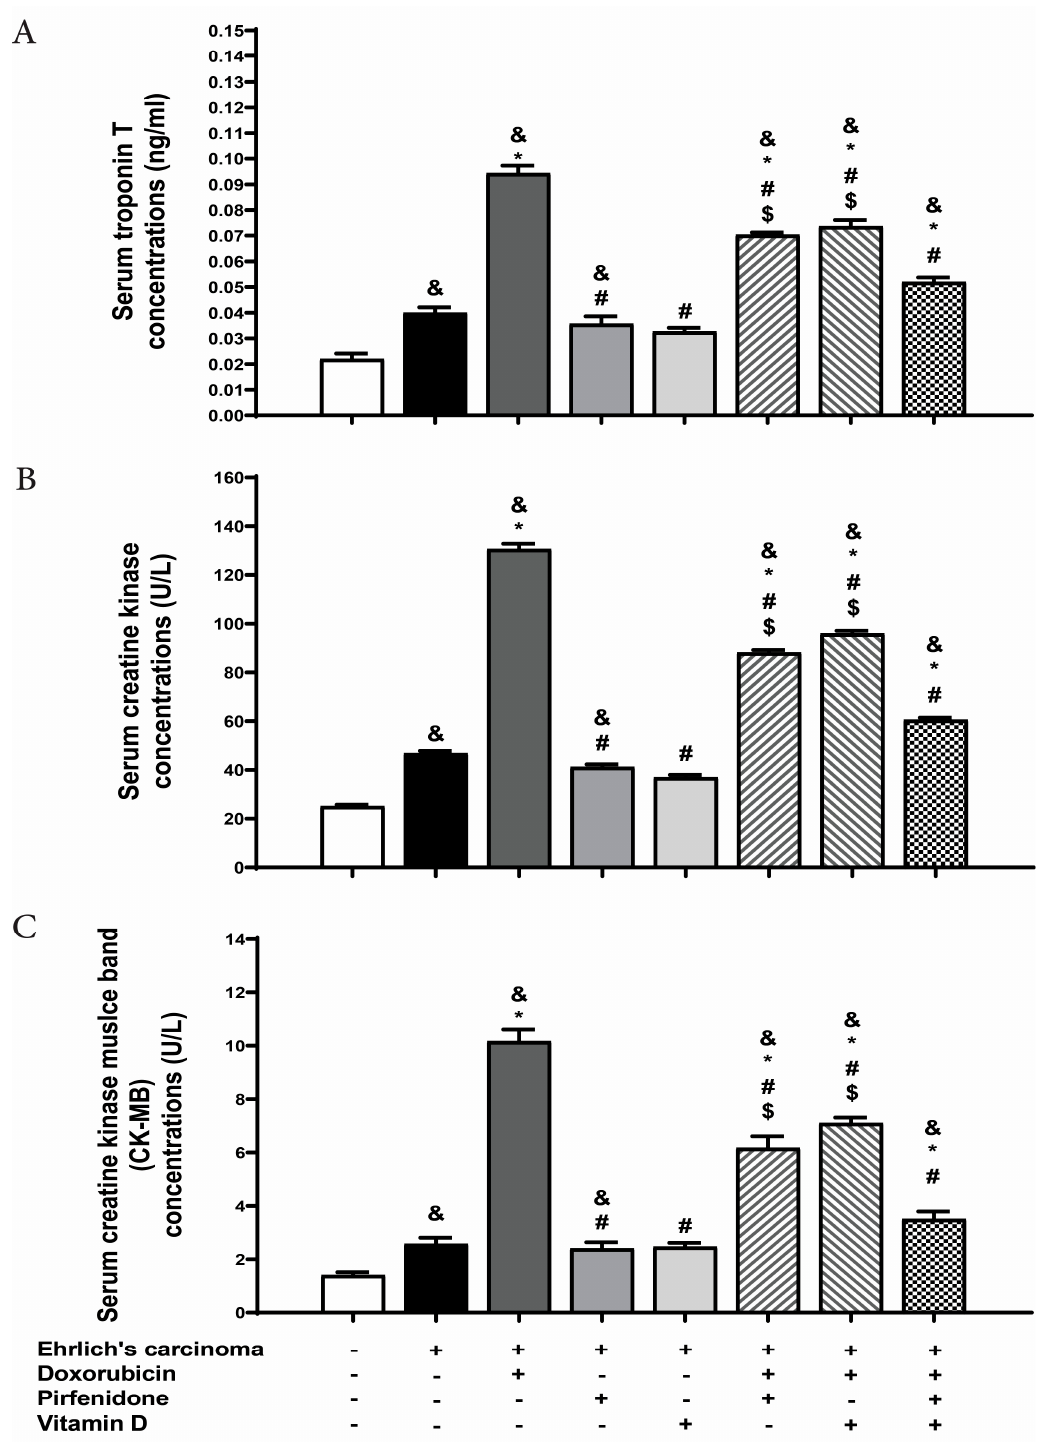
Figure 1. Effect of individual treatment with doxorubicin (15 mg/kg; i.p.), pirfenidone (500 mg/kg; p.o.) or vitamin D (0.5 μ g/kg; i.p.) and their combinations on the levels of biochemical markers ( A ) serum troponin and ( B ) creatine kinase (CK) ( C ) CK ‐ MB in EAC bearing mice on day 21. Results are expressed as mean ± SEM. All data were analyzed using ANOVA followed by Bonferroni’s post ‐ hoc test at p < 0.05. & p < 0.05 with respect to normal, * p < 0.05 with respect to control EAC, # p < 0.05 with respect to doxorubicin. $ p < 0.05 with respect to the co ‐ therapy of doxorubicin, pirfenidone, and vitamin D ( n = 5).